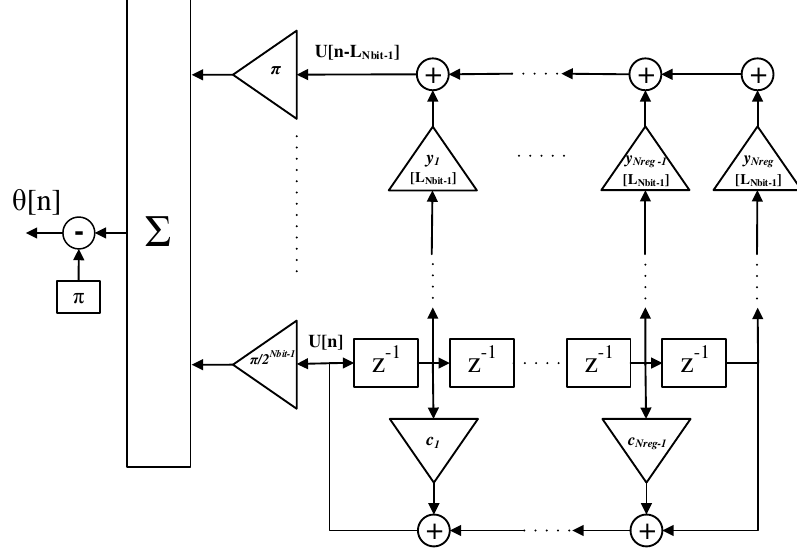
Figure 5. Overall schematic of the phase